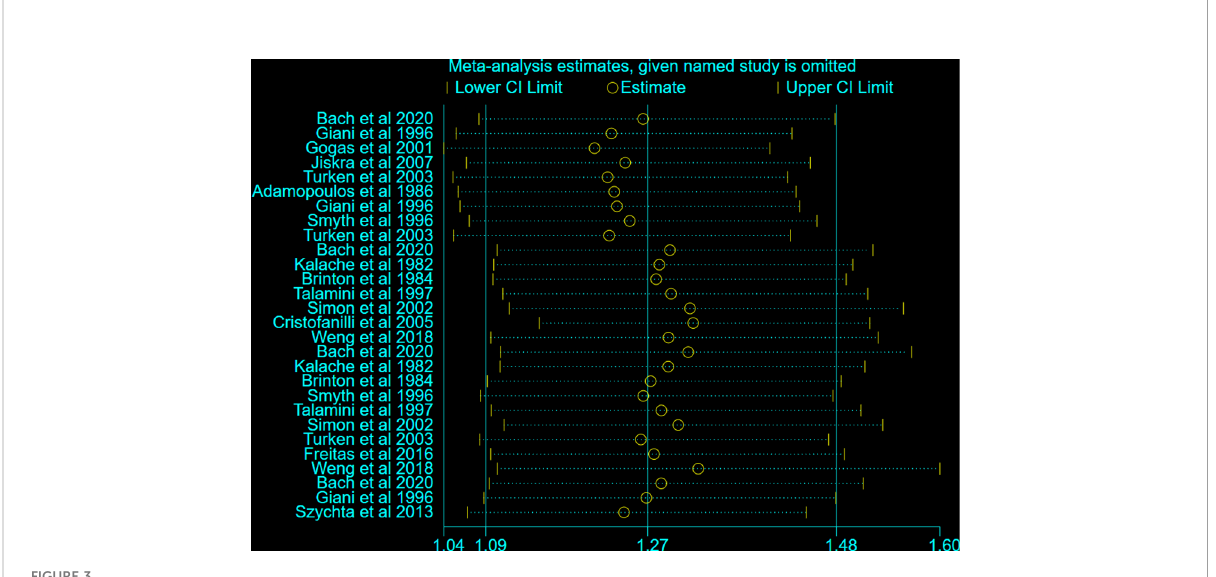
FIGURE 3 Sensitivity analysis on the BTD and BC